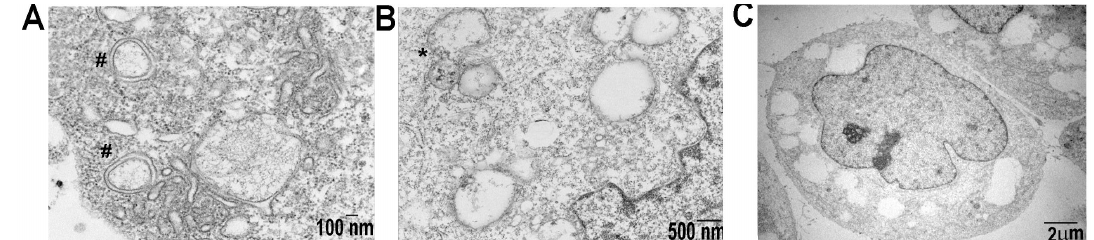
Figure 4. Transmission electron microscopy demonstrates ultrastructural features of S2VP10 cells treated with echinomycin. ( A ) Autophagosomes (#) are visible. ( B ) Joining of autophagosome with the lysosome (autolysosome *). ( C ) Plasma and nuclear membranes are intact and lack of significant changes in chromatin structure. Approximately 35% of cytoplasmic space observed contains large vacuoles.